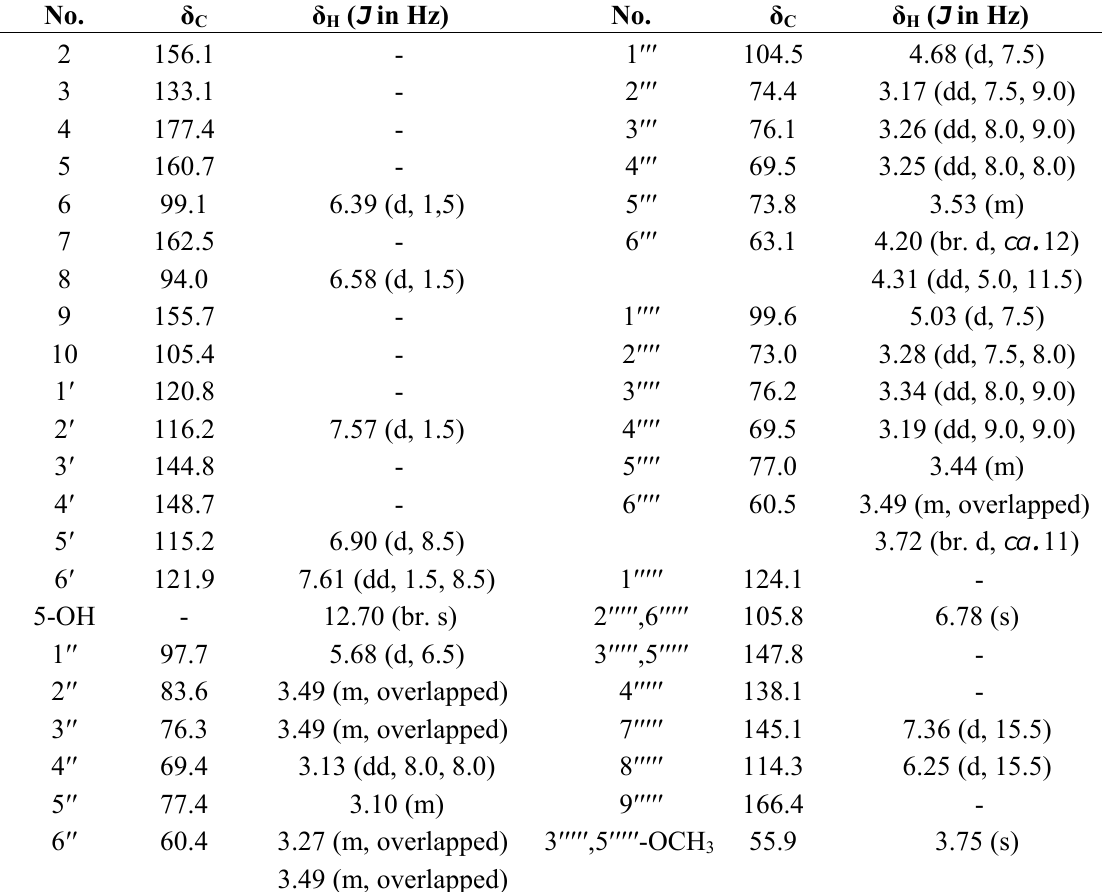
Table 4. 1 H and 13 C-NMR data for 4 in DMSO- d 6 (500 MHz for 1 H and 125 MHz for 13